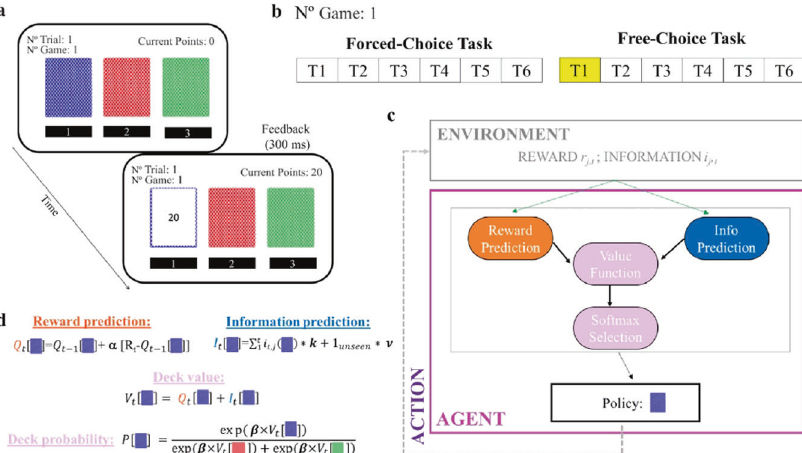
Fig. 1 Behavioral task and RL model. a On each trial, participants made choices among three decks of cards. After selecting a deck, the card fl ipped and revealed the points earned, between 1 and 100 points. Participants were instructed to attempt to maximize the total points earned by the end of the experiment. b On each game, participants played a forced-choice task (six consecutive trials) followed by a free- choice task (variable between 1 and 6 trials) on the same three decks. Subjects earned points only in the free-choice task. c On each trial, the novelty-knowledge RL (nkRL) model computes an option value function according to both experienced reward and information associated with each option, then the model generates a choice by passing the option values through a softmax function. d For each chosen option, nkRL uses a delta rule to update the reward prediction ( α parameterizes the learning rate) and updates information prediction as to the sum of general information (total number of times an option has been chosen) and a novelty term. The general information term describes the level of general information participants have about the selected option, while the novelty bonus is assigned to options the outcome of which has never been experienced in previous trials. Reward and information predictions are then combined into an overall action value, which is combined across options through the softmax function (whose randomness is parameterized by the inverse-temperature parameter β ). Model parameters are shown in